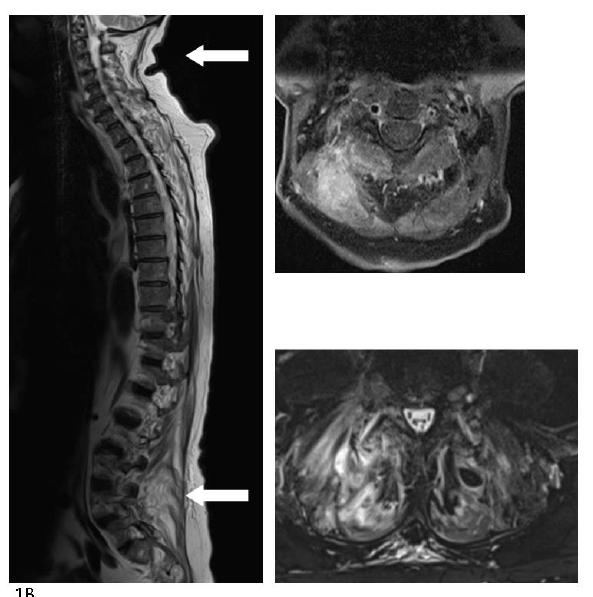
Figure 1. A 64-year old man was admitted to a local hospital with sudden onset of fever, difficulty breathing, and chronic chest and back pain. The patient’s prior medical history included stroke